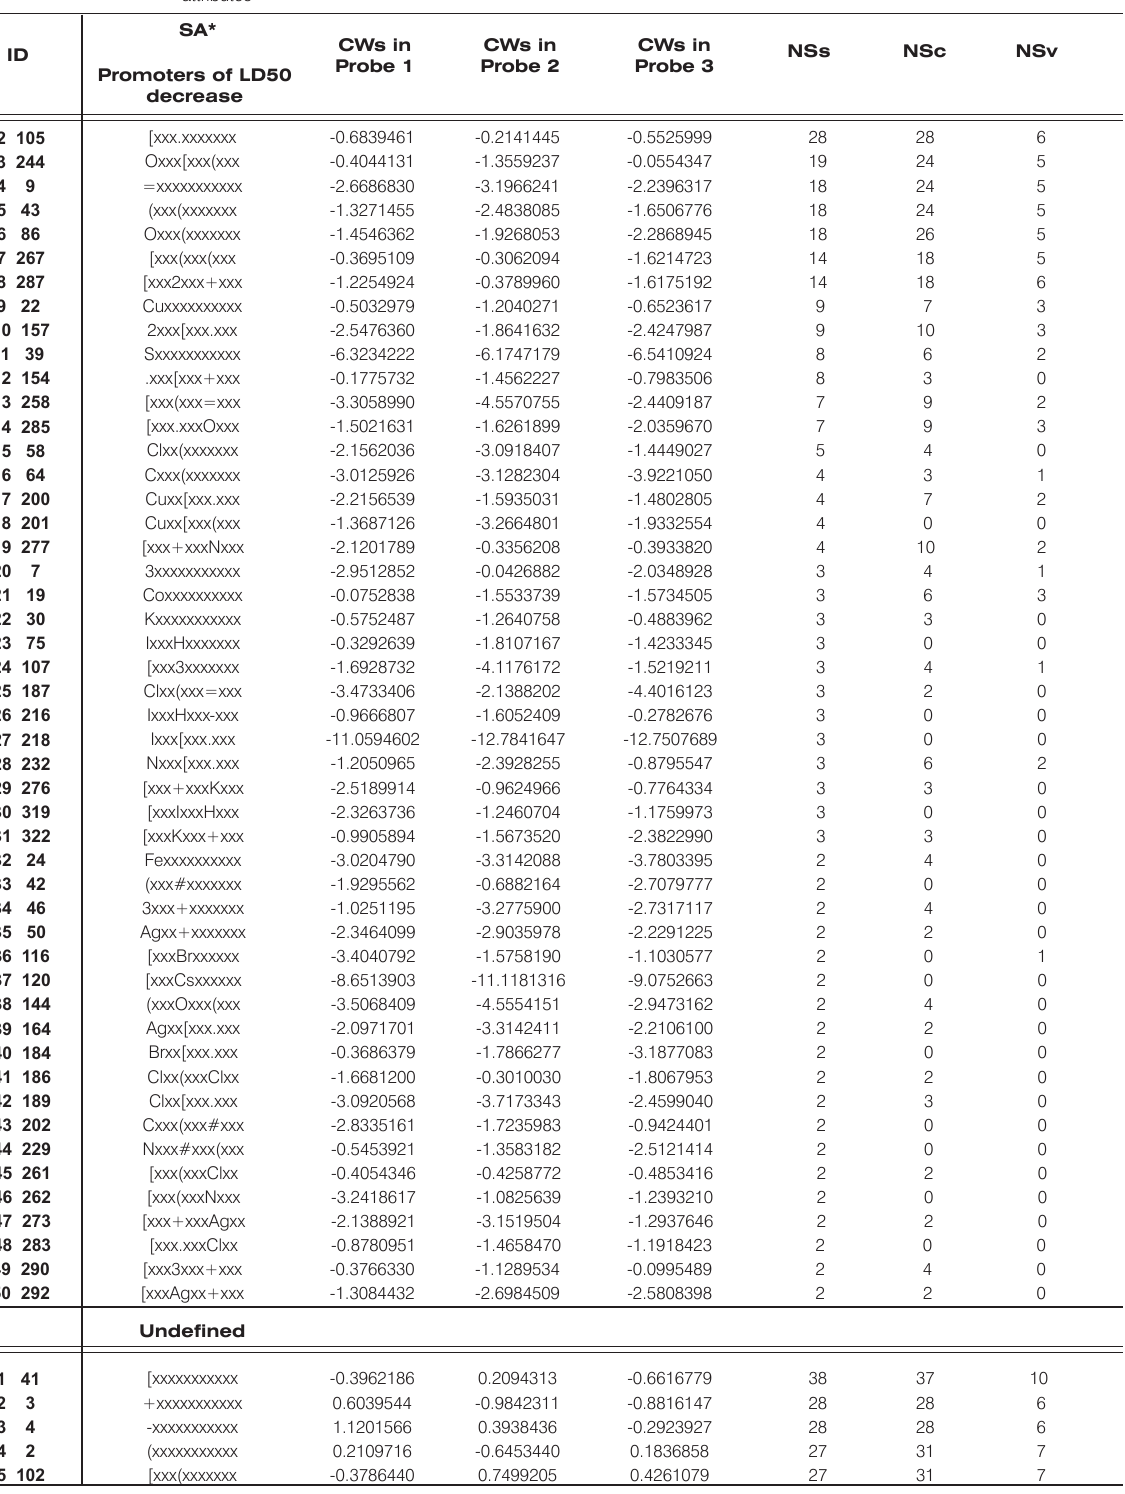
Table 2. Correlation weights of SMILES attributes (SA) which have been obtained for split A using the threshold 2. ID contains two Contiuned integers: the first is numbering for the given category; the second is the number of SA in the general list of SA for all 85 substances. The NSs, NSc, and NSv are the numbers of SMILES which contain the SA in the subtraining, calibration, and validation sets, respectively. The ‘x’ denotes a vacant place in the string (twelve symbols) assigned for registration of